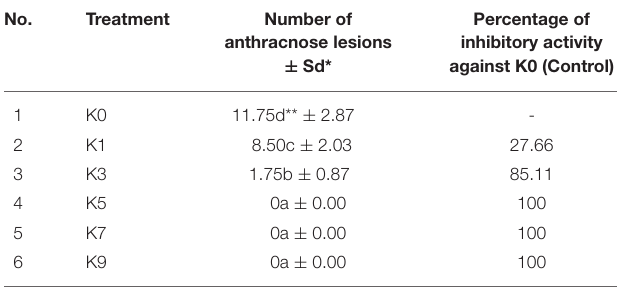
TABLE 3 | Effects of concentration of formulation F6 on the number of anthracnose lesions on chili pepper fruit cultivar Cabe Besar in vivo . No.